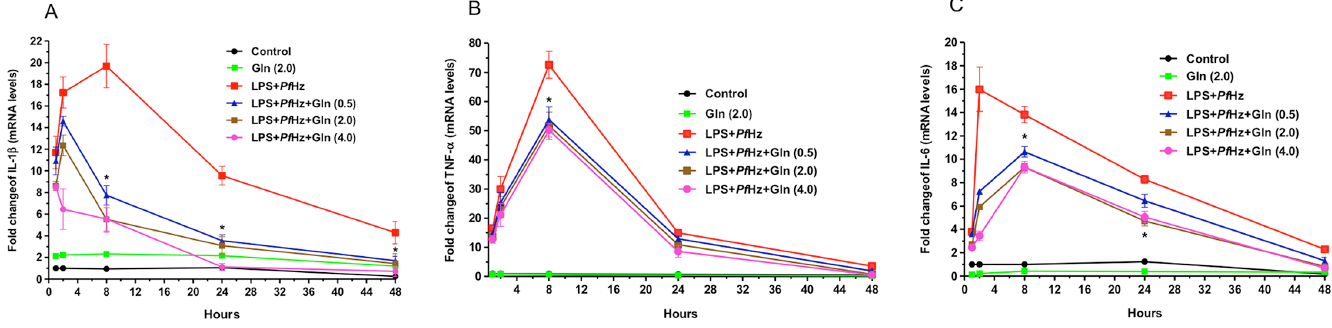
Figure 8. Effect of glutamine treatment on Pf Hz-mediated inhibition of proinflammatory mediators (IL-1 β , TNF- α and IL-6). Peripheral blood mononuclear cells (2.5 × 10 6 ) were incubated with LPS for 1 h prior to Gln treatment (0.5, 2.0 and 4.0mM, pretreated 30 min prior to add- ing Pf Hz) for different time points. Total RNA was isolated and gene expression analysis by qRT-PCR was performed to quantify the cyto- kine transcripts using TaqMan ® gene expression assays. β -actin was used as an endogenous control to normalize the data by the ΔΔ CT method. Data represent average of individuals (n = 3) with each condition performed in triplicate (error bars represent SEM). * indicates P < 0.05 (one-way ANOVA) for Gln treatment relative to LPS + Pf Hz. (A) IL-1b mRNA fold change. (B) TNF- α mRNA fold change. (C) IL-6 mRNA fold